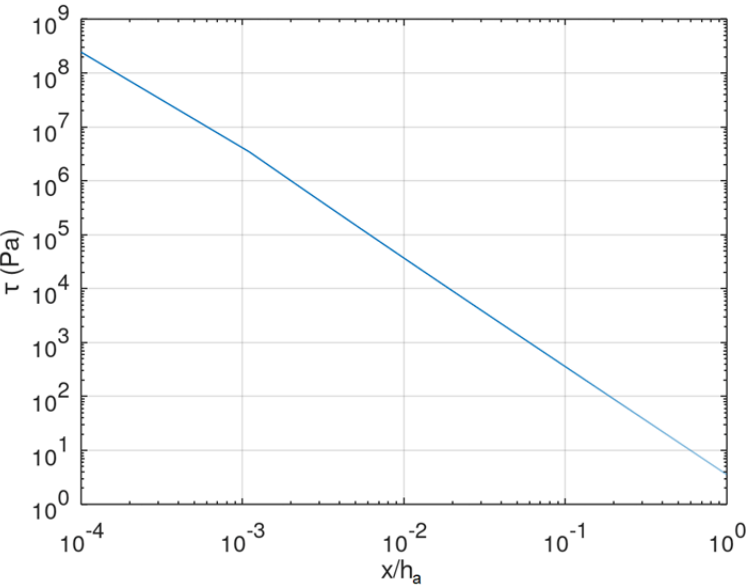
Figure 7. Shear stress calculated using equation 7 of the far edge approximated solution in function of the distance from the plate edge being normalized by film thickness.